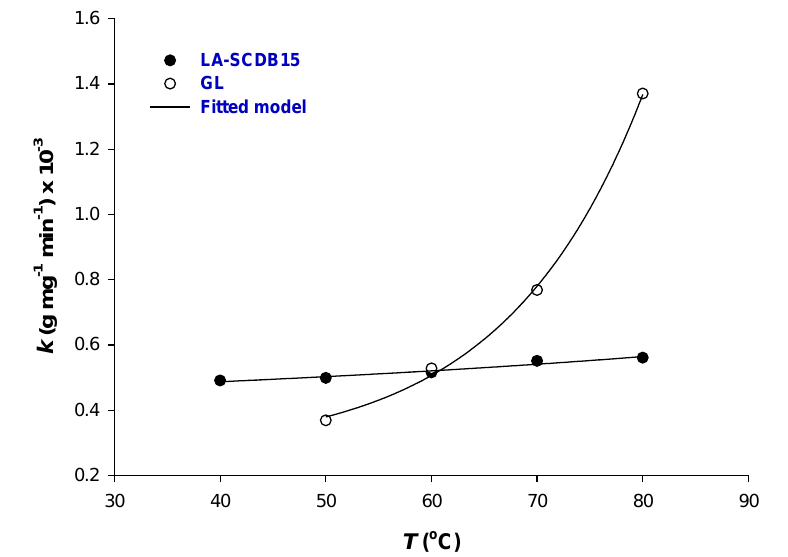
Figure 7. Non-linear regression between second-order extraction rate values, k , and T . Data concerning the extraction with 60% glycerol/water (GL) were obtained from Grigorakis et al., 2020.